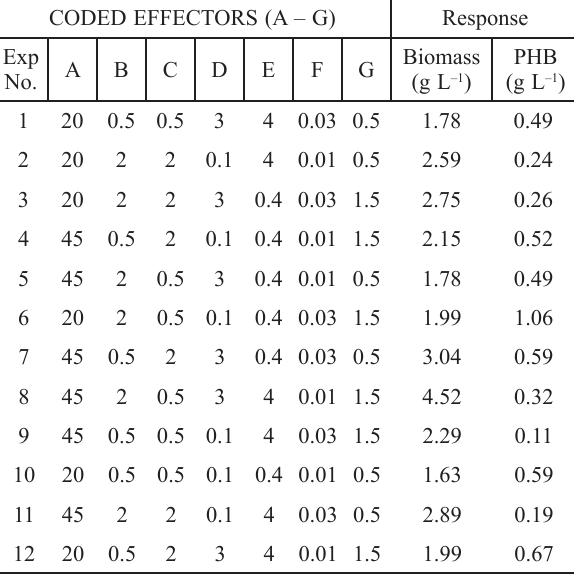
Table 2 – Experimental Design of Plackett-Burman Protocol along with their Responses (biomass and PHB)